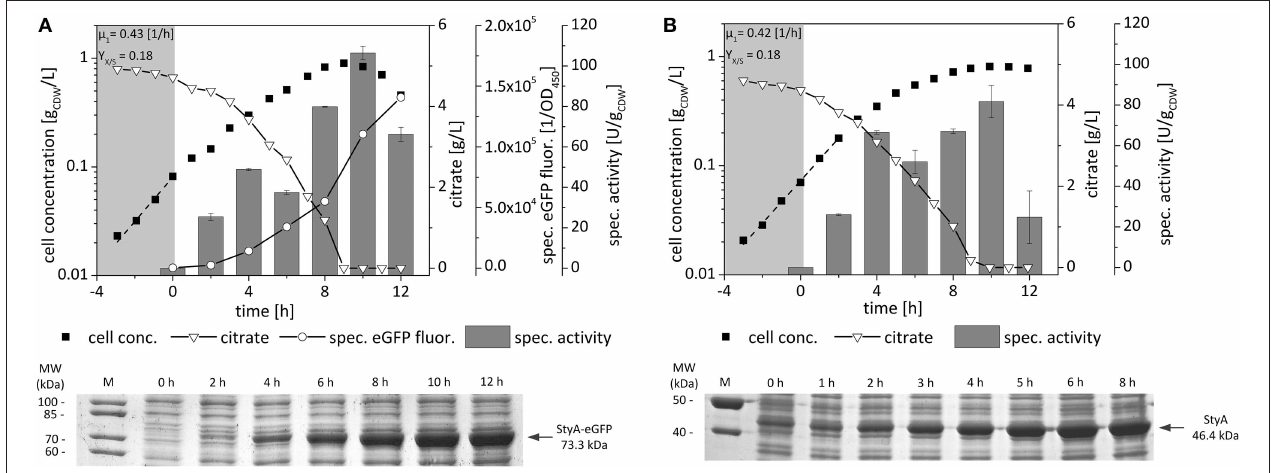
FIGURE 1 | Growth, expression, and specific styrene epoxidation activity profiles of P. taiwanensis VLB120 (pA-EGFP_B) (A) and P. taiwanensis VLB120 (pStyAB) (B) grown on citrate as sole carbon source. Cells were cultivated in M9 * medium and induced with 0.025% (v/v) DCPK after 3h of growth. Samples for resting-cell activity, specific fluorescence, and SDS-Page analyses were taken at regular time intervals (every 2h) after induction. For determination of the specific styrene epoxidation activity, cells were harvested, resuspended in KPI buffer containing 0.5% (v/v) citrate, and supplied with 1.5mM styrene to start the reaction. Growth rates [h − 1 ] were determined during exponential phase (dashed line). Yields on citrate were determined after inoculation and at the time point of citrate depletion. Error bars represent standard deviations of two independent assays.